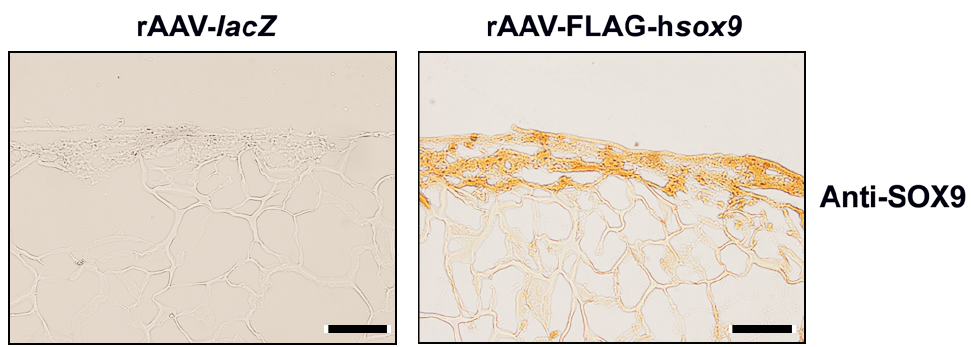
Figure 2. Detection of transgene (SOX9) expression in hydrodynamic cultures of rAAV-transduced hMSCs seeded in fibrin-PU scaffolds. Cells were transduced with rAAV- lacZ or rAAV-FLAG-h sox9 (40 µL each vector), seeded in PU scaffolds, and cultivated in rotating bioreactors for 21 days using chondrogenic medium as described in Figure 1 and in Materials and Methods. Samples were processed after bioreactor cultivation to detect immunoreactivity to SOX9 (magnification ×10; scale bar: 200 µm; representative data). Note the highest presence of immunoreactivity to SOX9 at the surface of the constructs which can be attributed to a diffusion gradient of the nutrients into the center of the constructs at homogenous cell seeding.